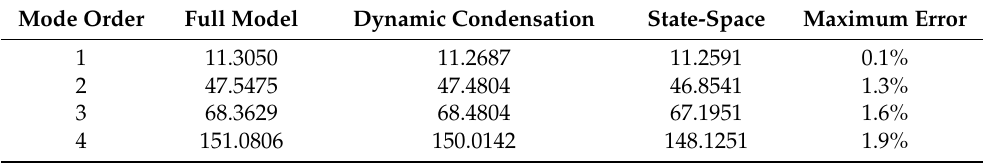
Table 3. Comparison of natural frequencies before and after model order